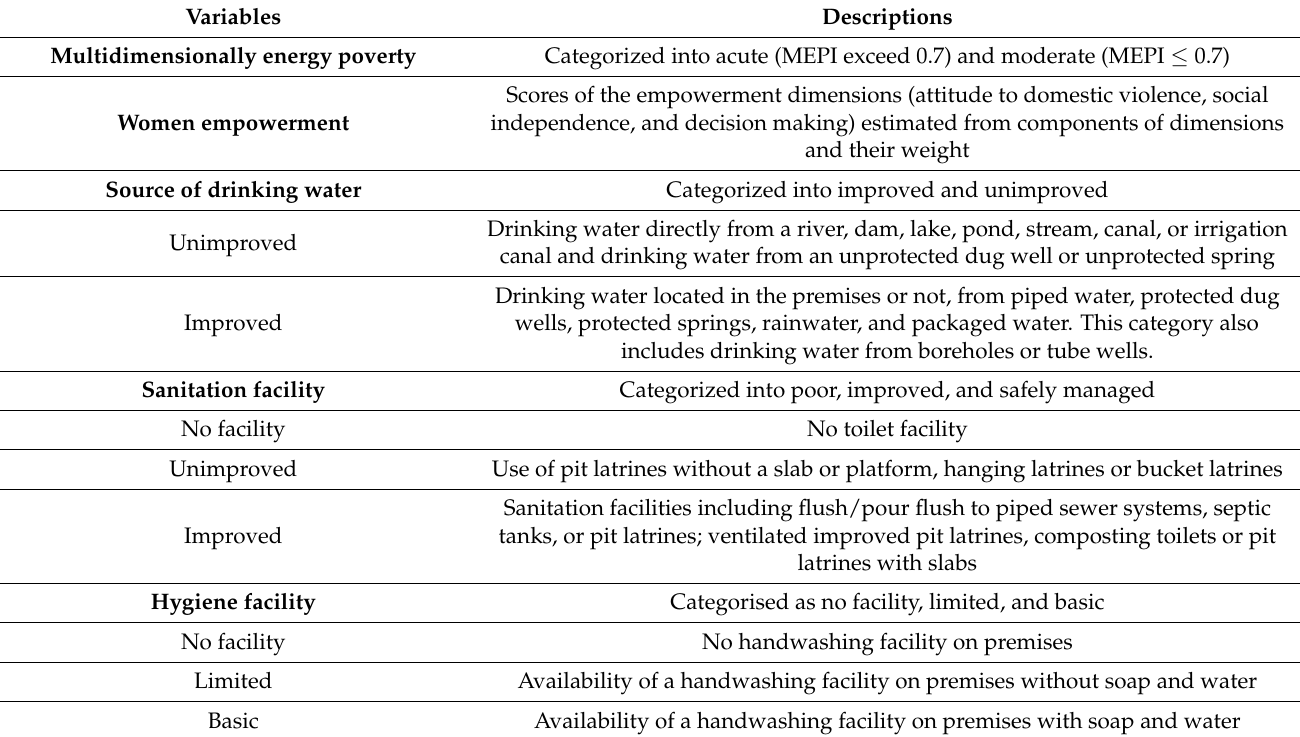
Table 2. Description of key predictors used in the